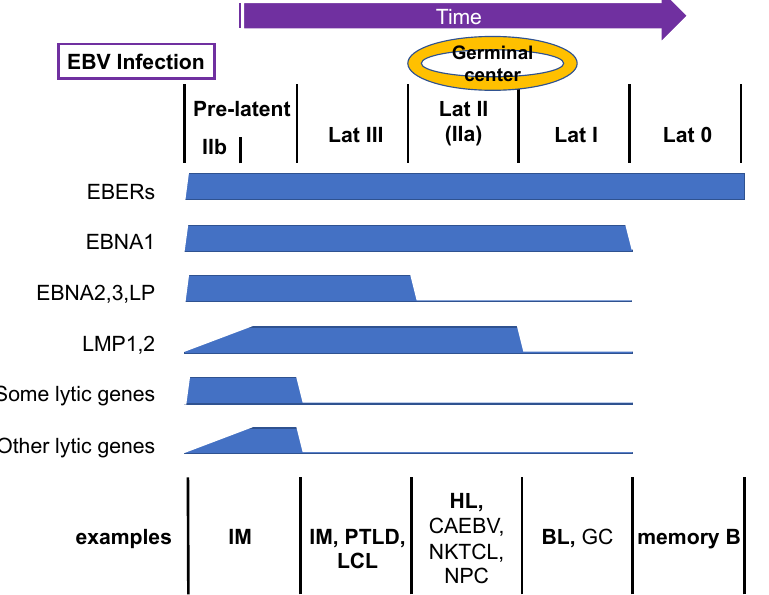
Figure 2. Transition of EBV gene expression upon primary B-cell infection. EBV infection of primary human B cells triggers the expression of both latent and lytic viral genes, which is termed the pre- latent phase. Subsequently, viral genes are silenced gradually. Example representative cells with the indicated patterns of viral gene expression in vivo are shown. Bold letters are B cells, and non-bold letters indicate non-B